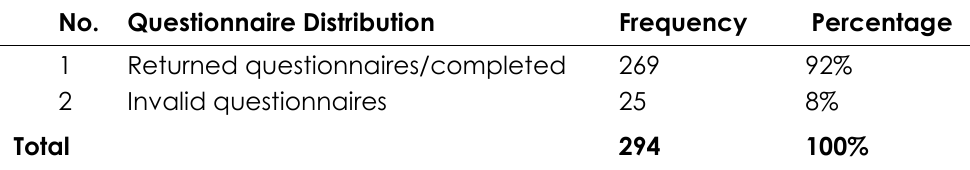
The Distribution of Questionnaires